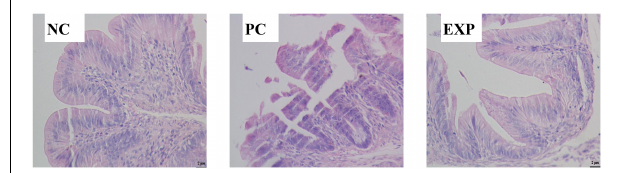
FIGURE 1 | Representative histopathology of cecal tisssues at 6 days post-infection. Three independent experiments showing similar results with 6–8 chicken per treatment. NC, the negative control group; PC, the positive control group; EXP, C. butyricum + S. enteritidis